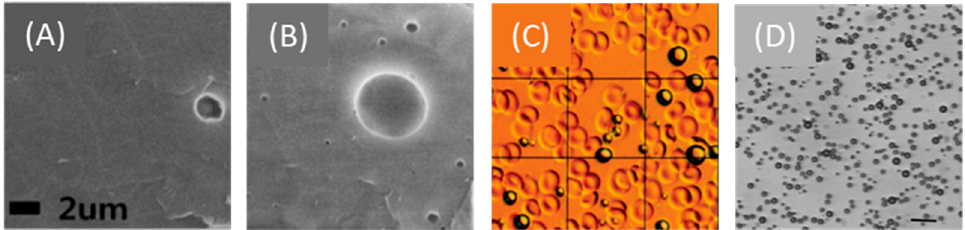
Figure 6. Commercially available microbubbles. Cryo-SEM images of ( A ) SonoVue TM and ( B ) Definity ® microbubbles. Adapted from [158], MDPI, 2013. ( C ) Optison TM microbubbles against a background of red blood cells. Adapted with permission from [159], RSNA, 2010. ( D ) Optical microscopy image of Sonazoid TM microbubbles. Adapted with permission from [160], Elsevier, 2008.